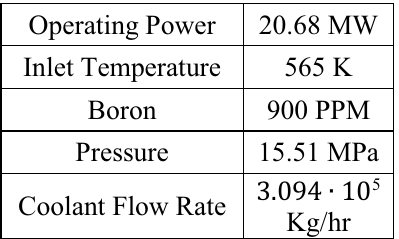
Table I. Assembly Parameters: Assembly operating parameters used in the optimization